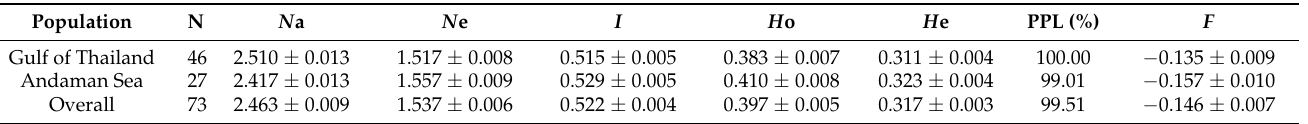
Table 1. Genetic diversity parameters of B. gymnorhiza (L.) Savigny in each of the two subpopulations and all accessions based on 1519